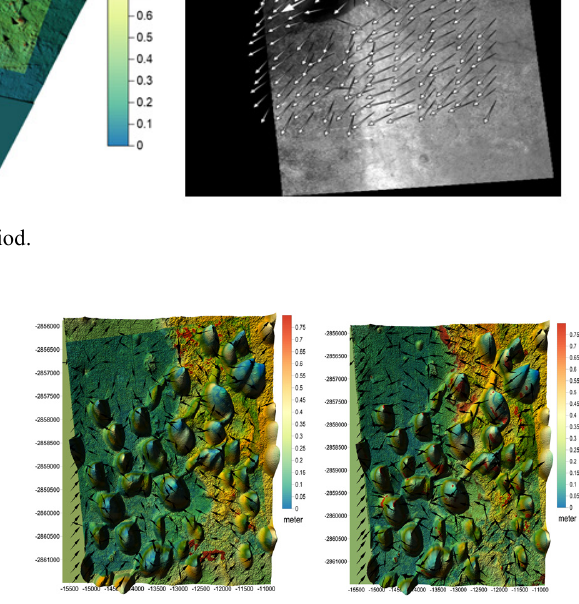
(a) Detected dune migration over the original HiRISE ortho- image Figure 7 . Traced dune migrations over Wirtz